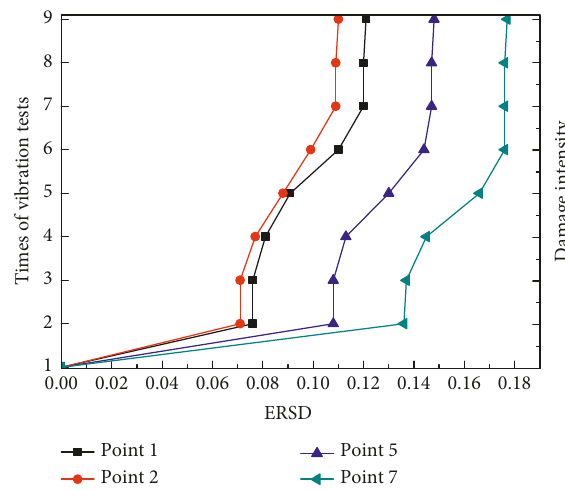
Figure 24: Trend chart of damage alarming indexes in field